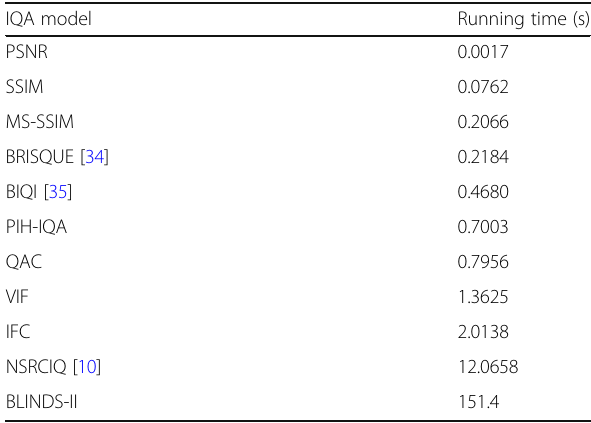
Table 3 Running time of the IQA